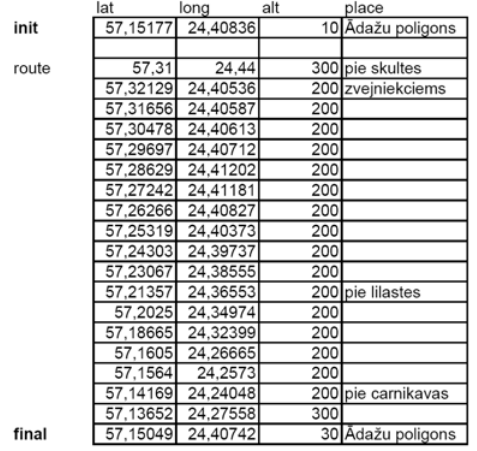
Fig 6. Definition of a generic UAV’s route by specifying waypoints and flyover altitude